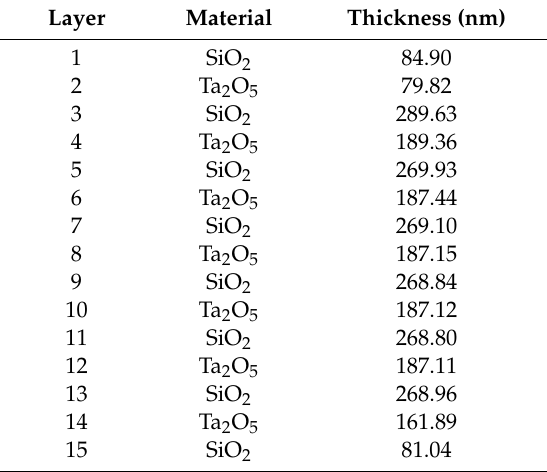
Table A1. Thickness of each coated layer in